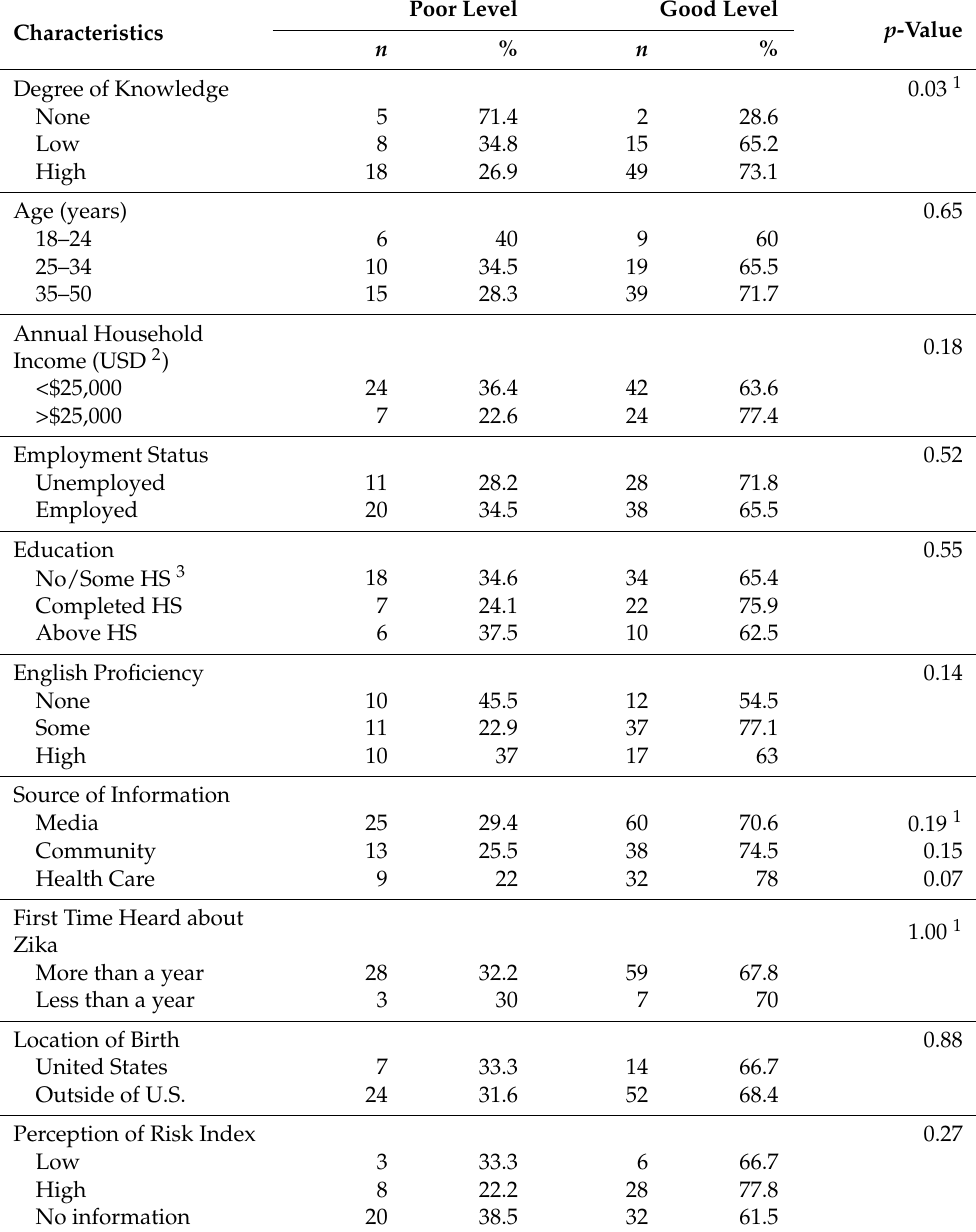
Table 2. Level of use of preventative measures by degree of Zika knowledge and sociodemographic characteristics in Latinas of childbearing age in South Florida ( n =